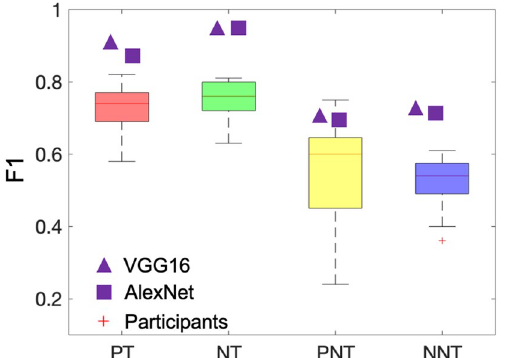
Figure 6. Comparison between the F1 achieved by participants and the one by neural networks which are trained from scratch in Supercharger level. Purple triangle represents the results using VGG16 while purple square represents the results by